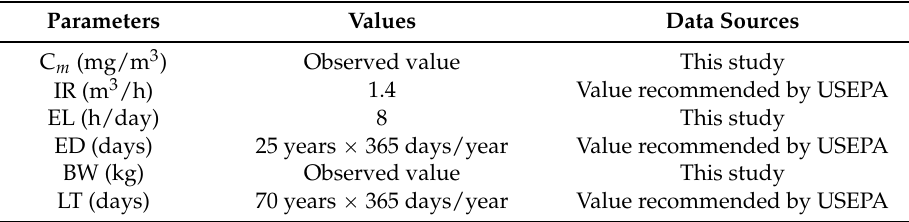
Table 1. Sources of parameter values in the exposure